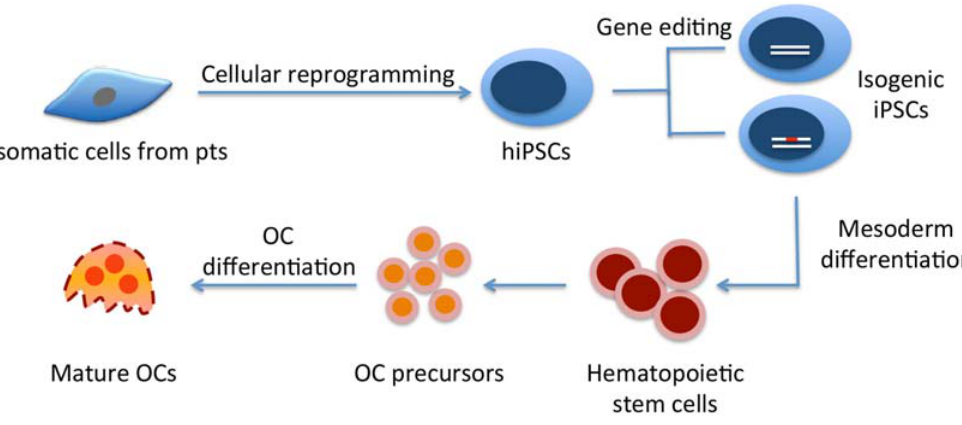
Figure 1. Summary of generating osteoclasts from human